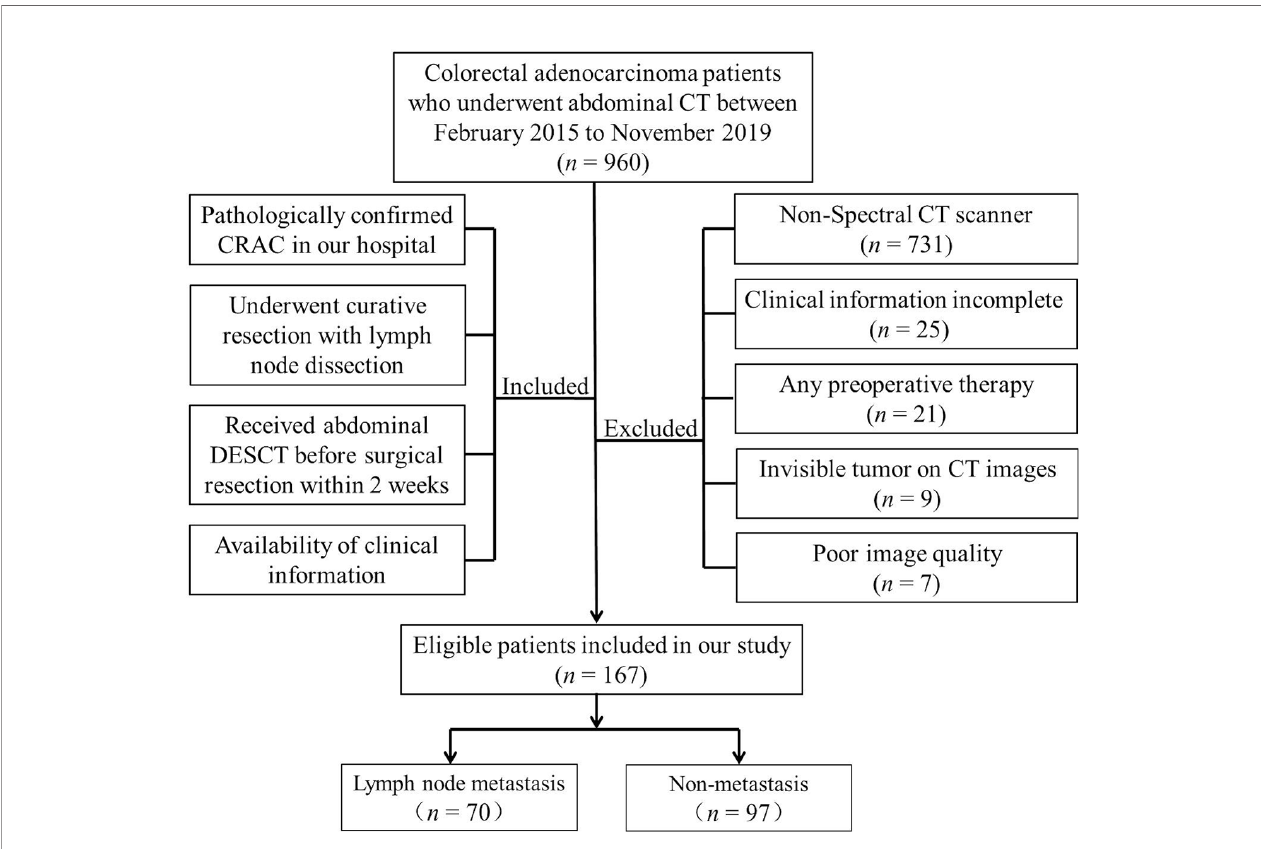
FIGURE 1 | A fl ow diagram of patient recruitment, including inclusion and exclusion